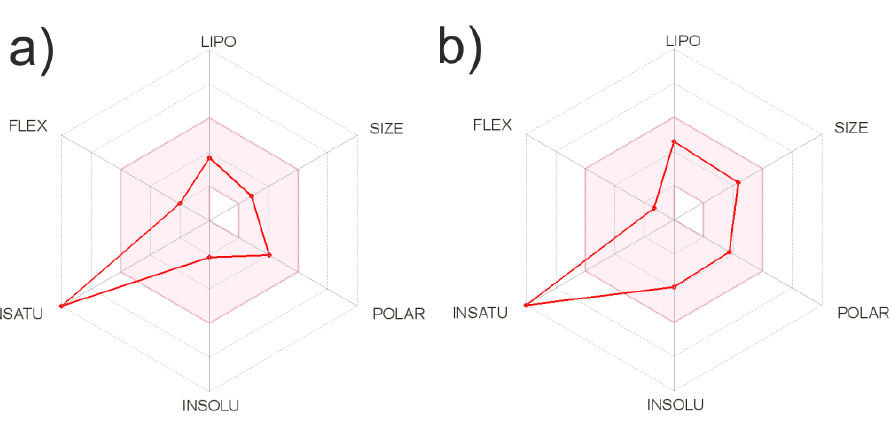
Figure 16. Bioavailability radar (lipophilicity (LIPO) are within the range − 0.7 < XlogP3 < +5.0; molecular weight (SIZE) are 150 g/mol < MW < 500 g/mol; polarity (POLAR) are 20 Å 2 < TPSA < 130 Å 2 ; insolubility (INSOLU) are 0 < logS < 6;—insaturation (INSATU) are 0.25 < Fraction Csp3 < 1; Flexibility (FLEX) are 0 < Num. rotatable bonds < 9) for ligand ( a ) and complex ( b ).